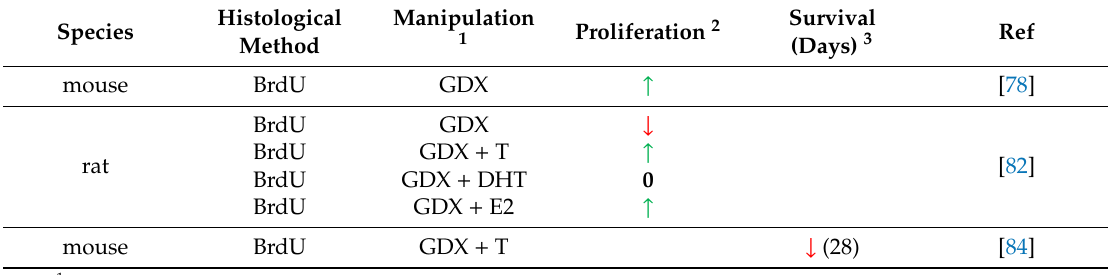
Table 1. Summary of research on the e ff ects of castration (GDX) and sex steroid manipulations on cell survival and proliferation in the subventricular zone and olfactory bulbs of male rodents relative to relevant control